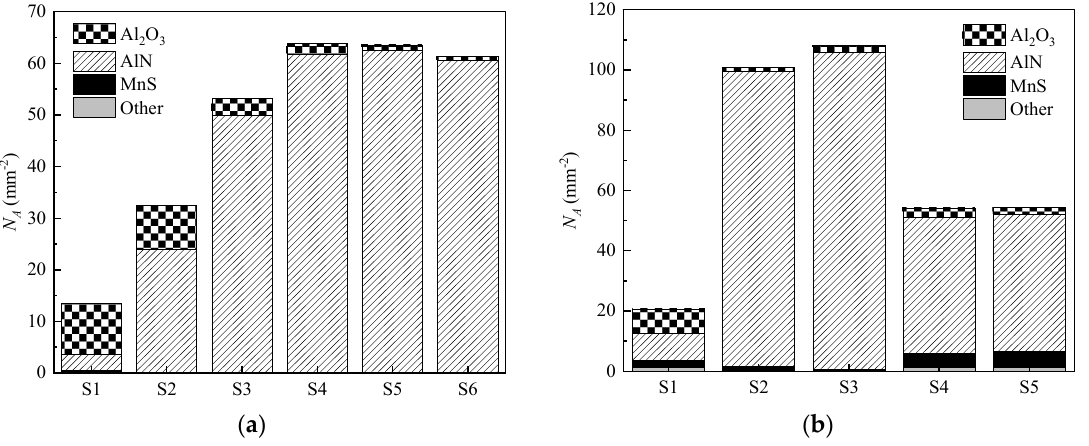
Figure 2. The total number of inclusions per unit area ( N A ) and their composition detected in ( a ) 533N-P and ( b ) 533N-I steel melts.